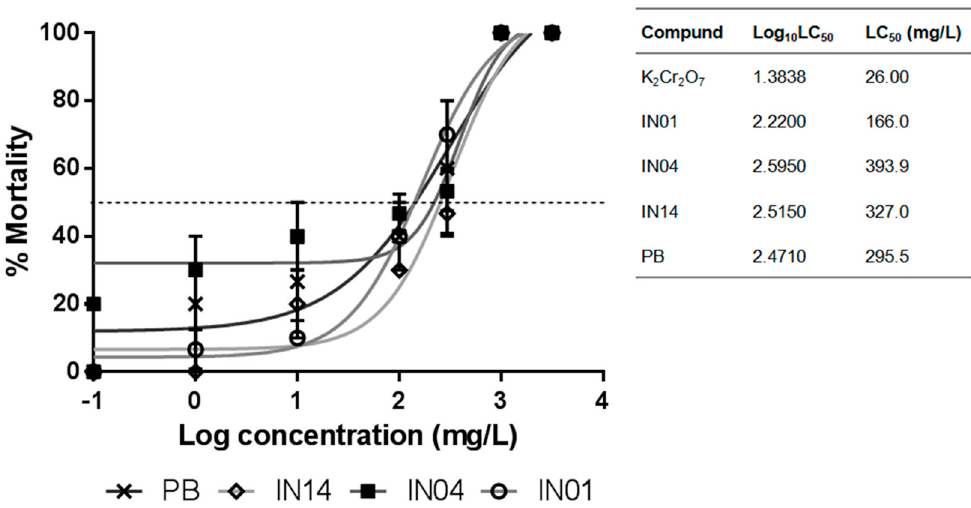
Figure 2. Percentage of mortality of A. salina exposed to HDAC inhibitors. Acute toxicity (LC 50 ) of IN01, IN04, IN14 and sodium phenylbutyrate (PB) on A. salina in seawater medium. The concentrations of the compounds (IN01, IN04 and IN14) and the HDAC inhibitor, phenylbutyrate (PB), are expressed in log10 concentration. Each point represents the mean ± SEM of 30 nauplii.